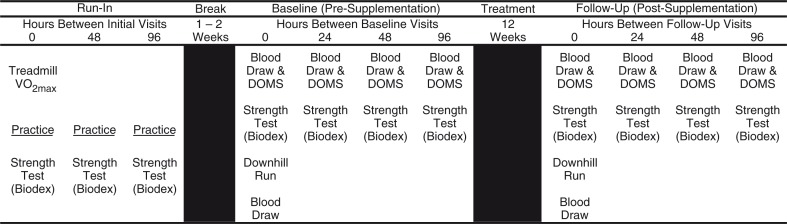
Overview of the clinical trial study design. The study design included three screening visits to facilitate equipment and protocol learning to remove learning effects and 4 days of criterion testing performed at baseline (pre-supplementation), following 12 weeks of supplementation. The post-supplementation testing period occurred during the 13th week of supplementation.